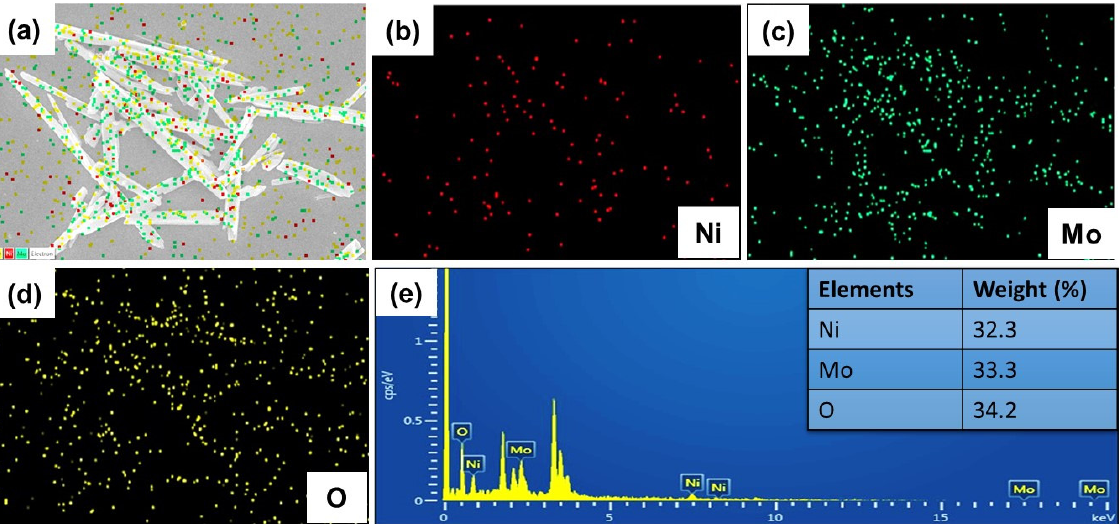
Figure 3. ( a – e ) High and low magnified FE-SEM images of NMO.